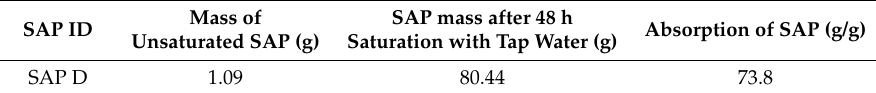
Table 3. Absorption potential of superabsorbent polymers (SAP) D in tap water environment based on the teabag method test.